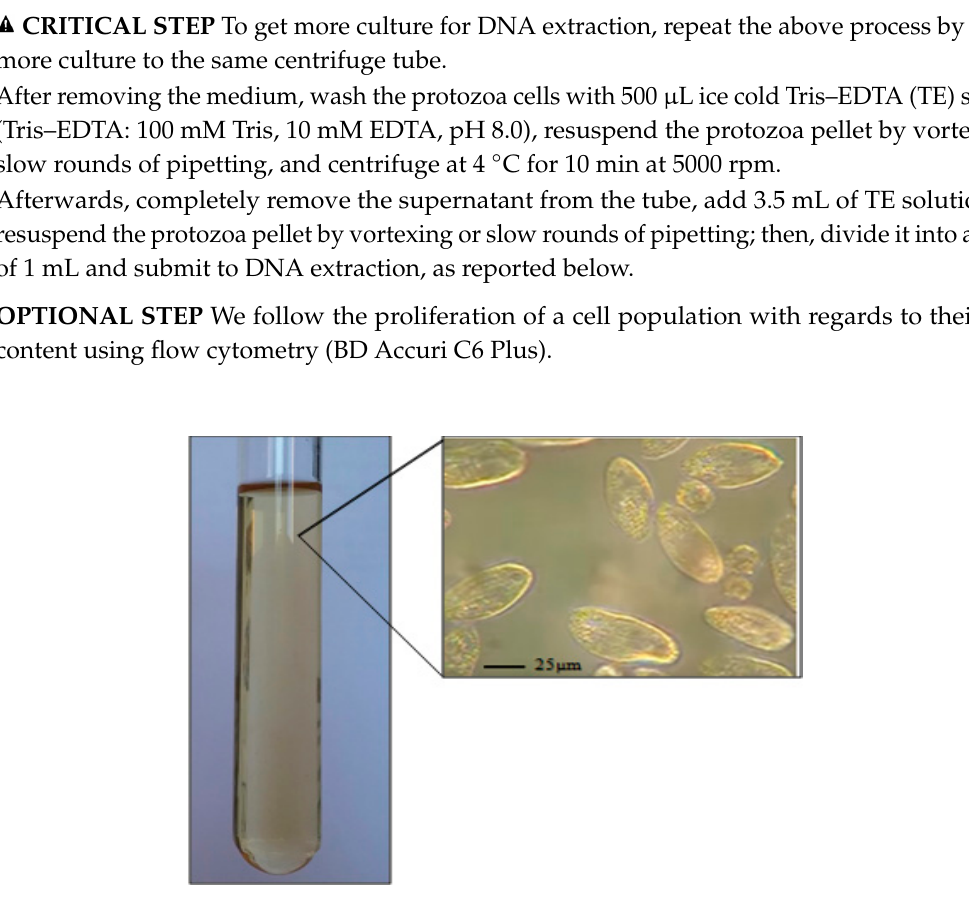
Figure 2. Microscopic image of Tetrahymena pyriformis (GL, L 1630/1) in proteose peptone-yeast extract medium (×100).